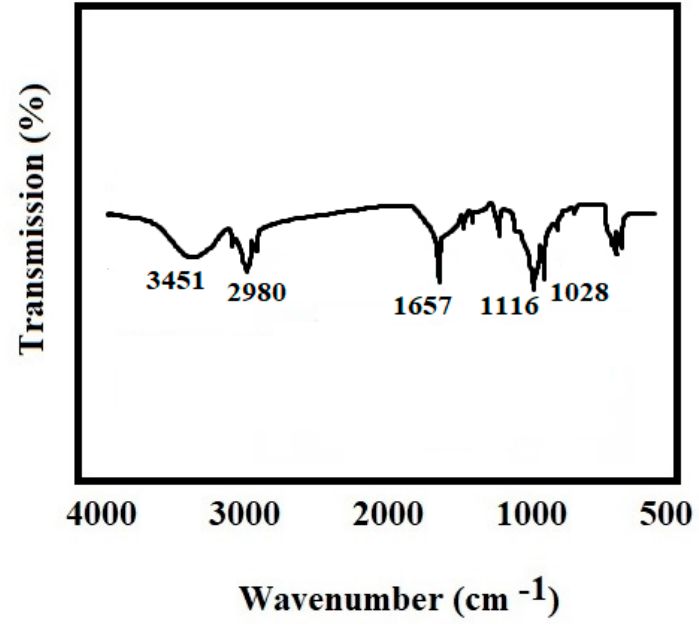
Figure 5. An FTIR spectrum for hydroxyapatite–gelatin/curcumin nanocomposites.